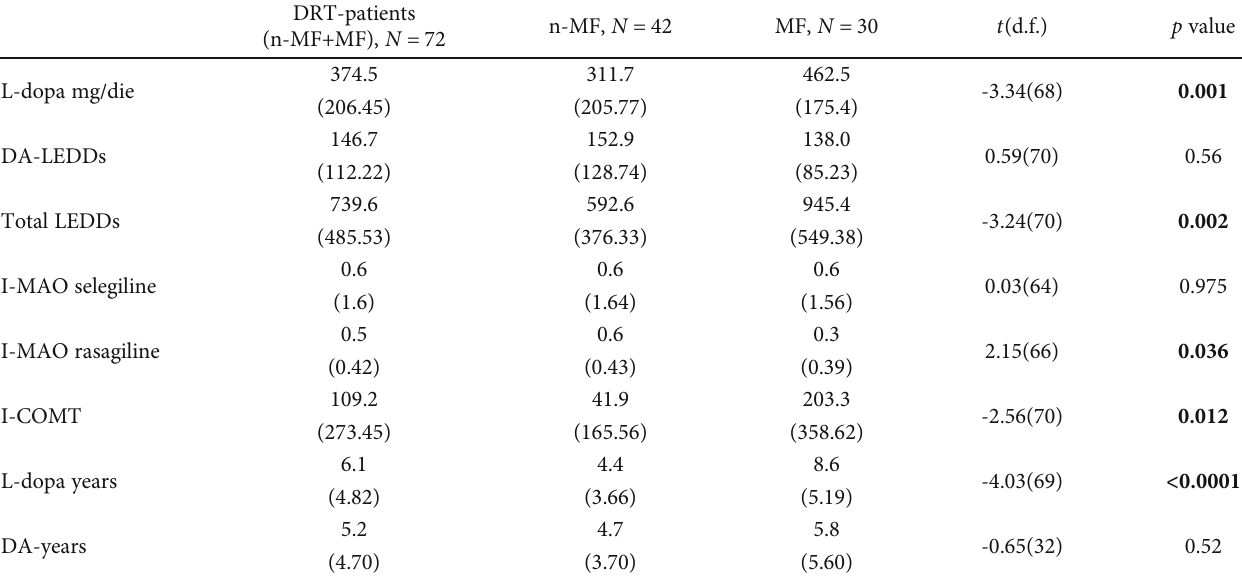
Table 2: DRT data of patients with Parkinson ’ s